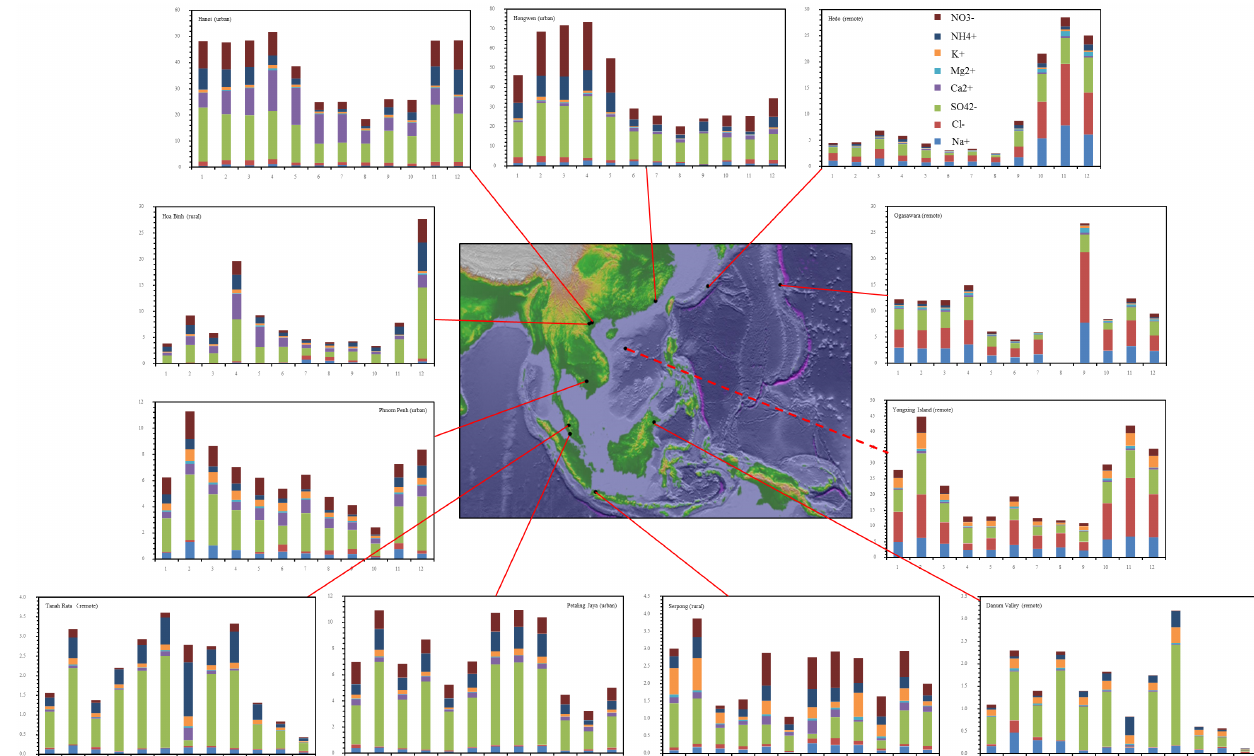
Figure 7. Comparison of aerosol chemical species between Yongxing Island and around the South China Sea (data from